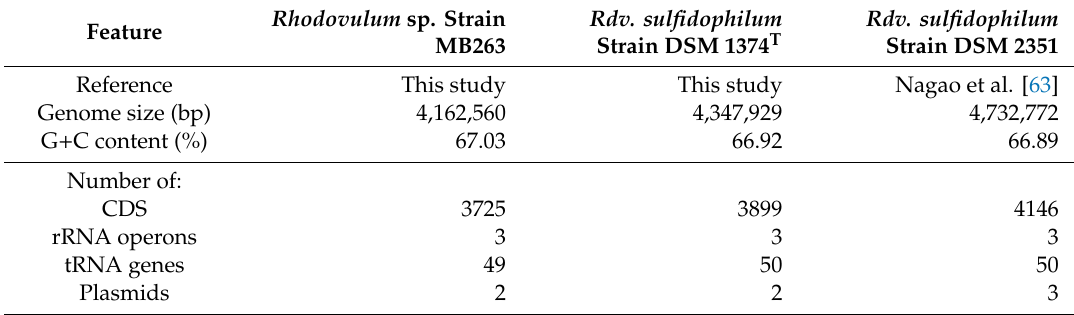
Table 2. Comparison of genome assemblies of Rhodovulum sp. strain MB263 and the two authentic strains of Rdv. sulfidophilum